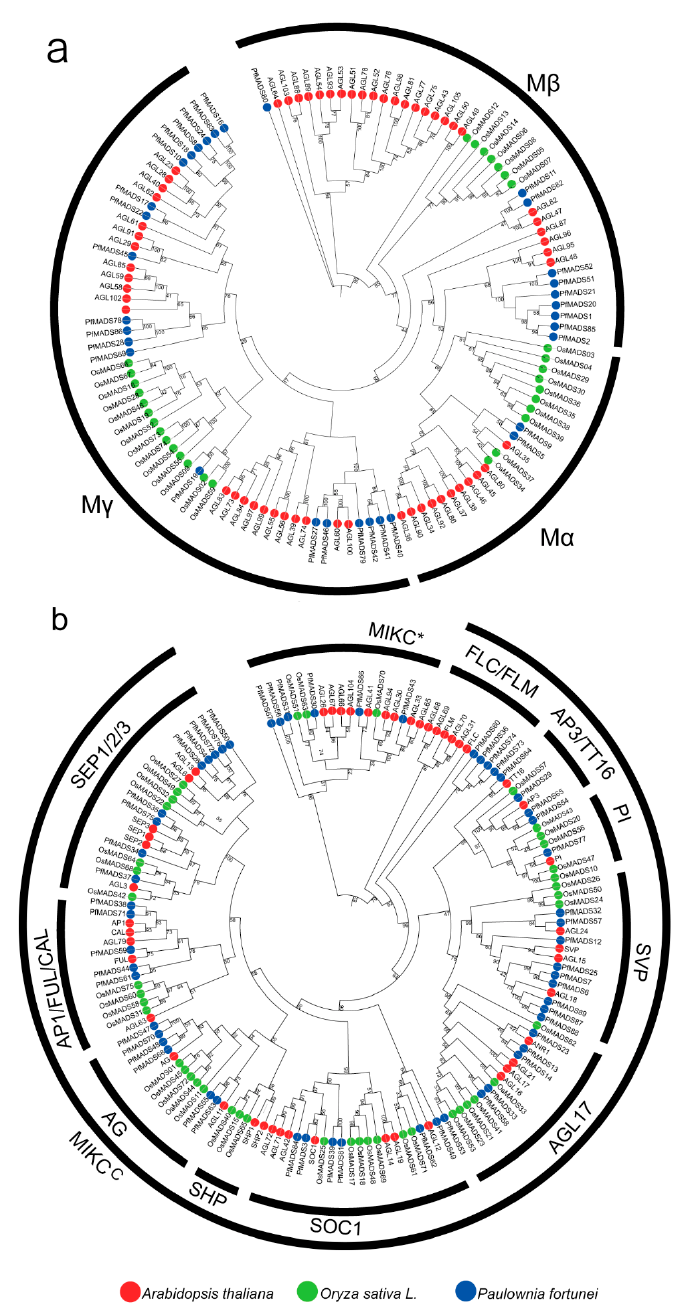
Figure 2. Phylogenetic analysis of type I ( a ) and type II ( b ) MADS-box proteins from P. fortunei , A. thaliana, and O. sativa. The MADS-box genes are labeled in red, green, and blue for A. thaliana, O. sativa , and P. fortunei, respectively.